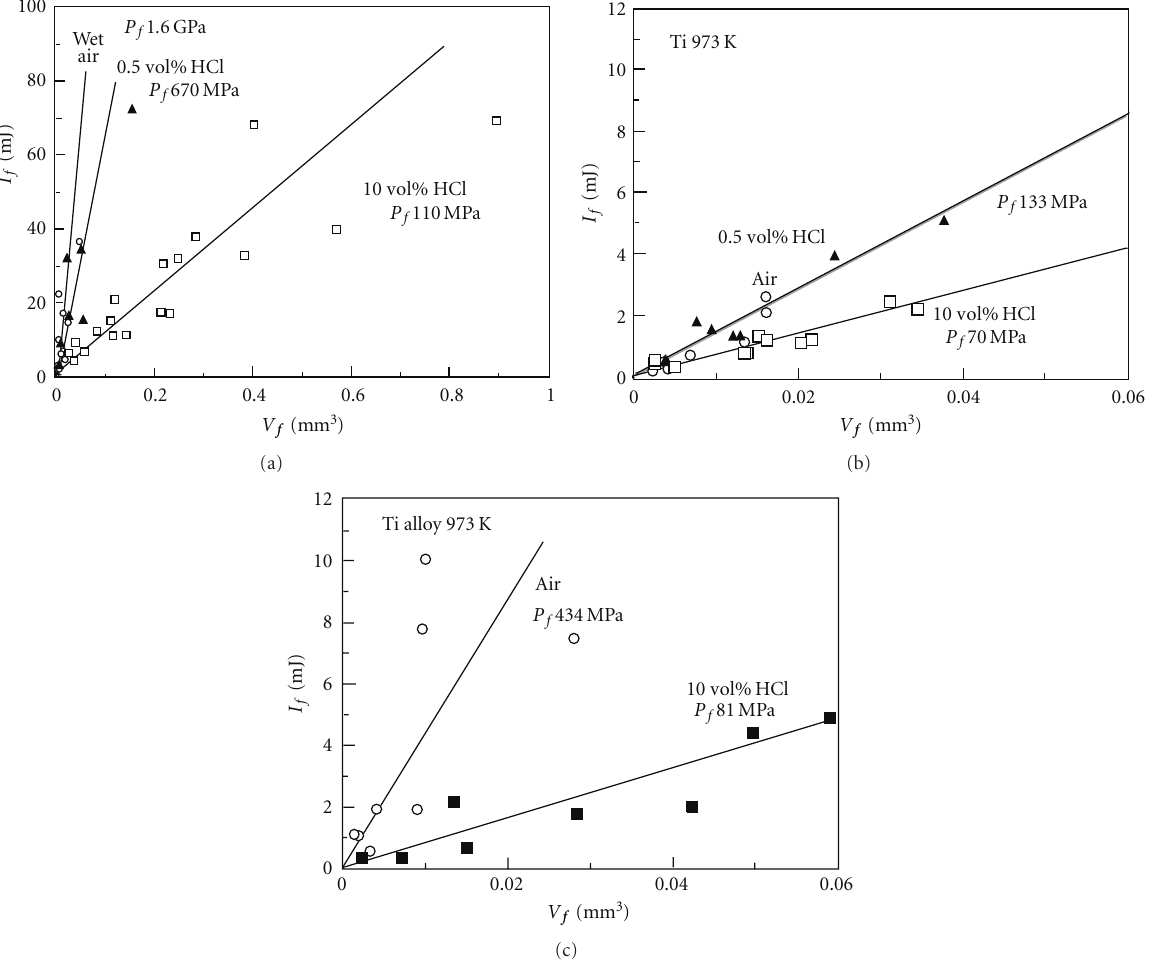
Figure 13: Relations between fracture energy and volume for (a) mild steel, (b) Ti, and (c) Ti alloy in various corrosive